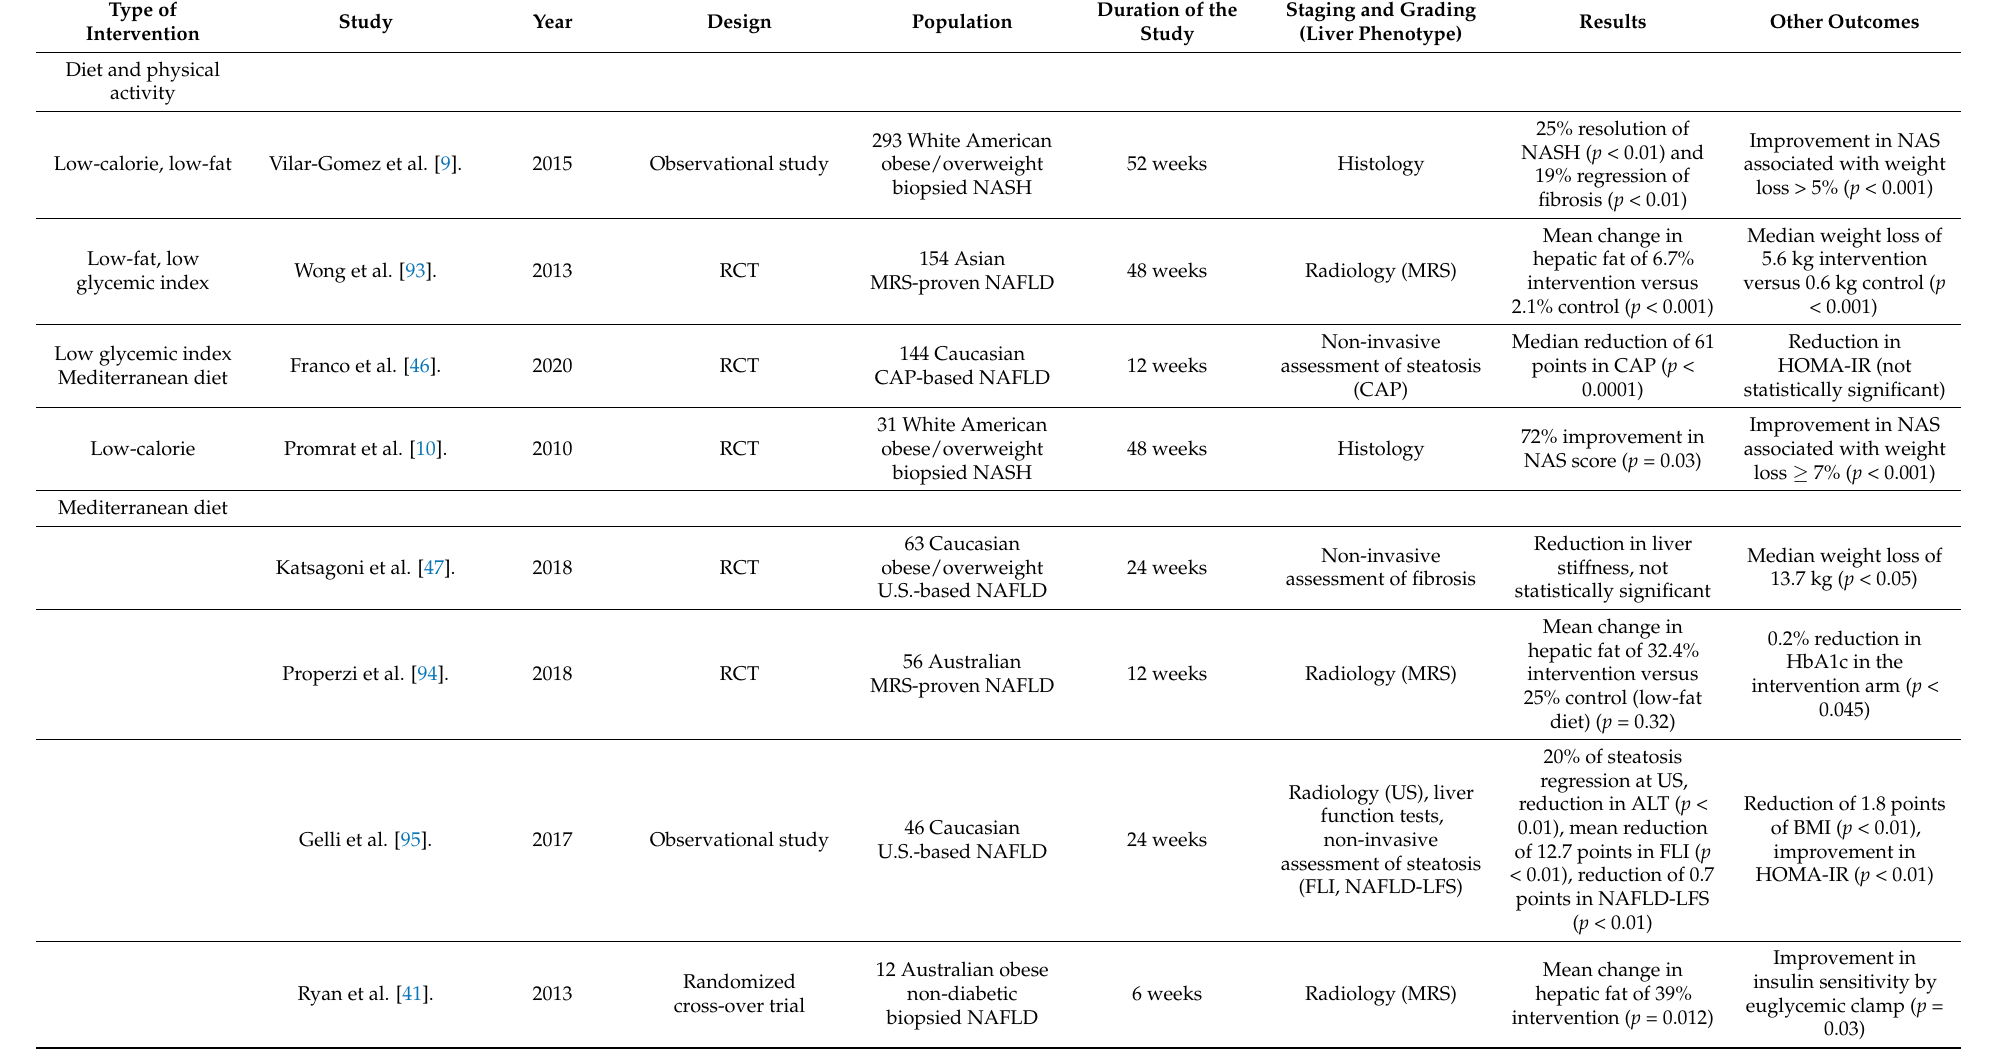
Table 1. Clinical studies evaluating the impact of different dietary pattern on both hepatic and metabolic